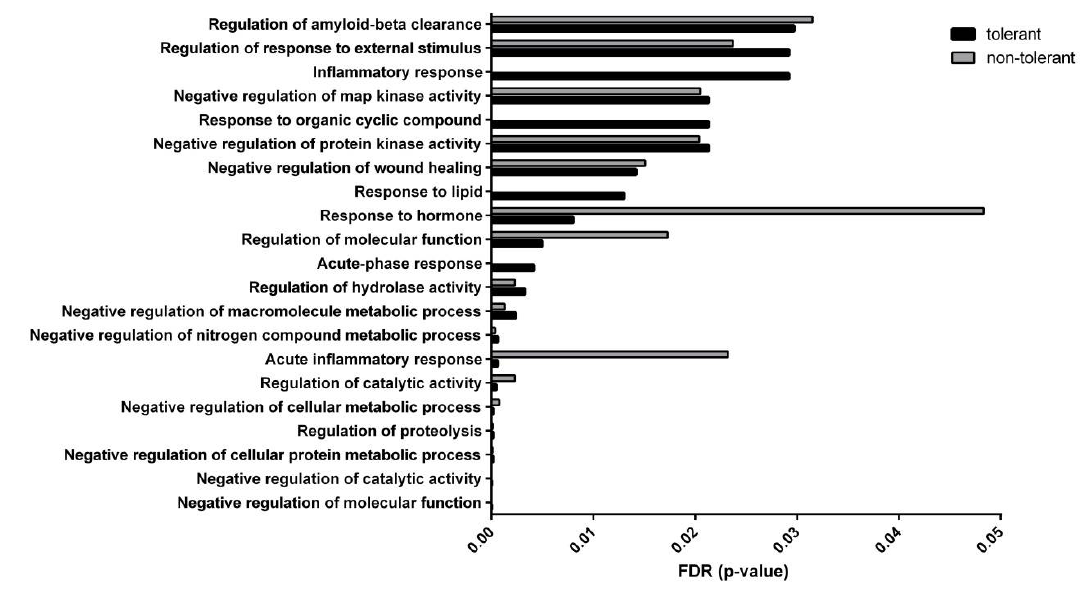
Figure 6. Comparison of the false discovery rate of the significantly enriched gene ontology terms in the bioactive fractions of blood cell-derived secretomes drawn from remote ischaemic condi- tioning (RIC)-treated and non-treated